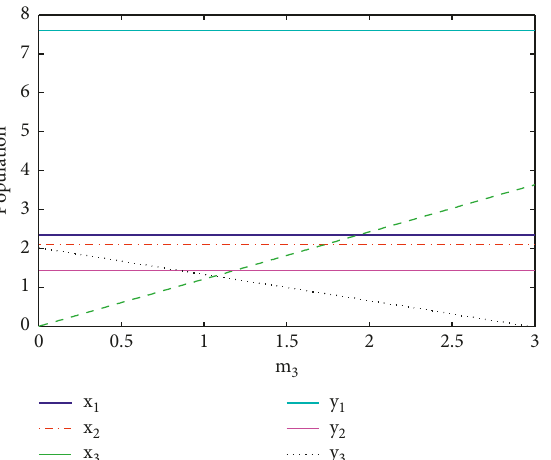
Figure 12: Variation of the system (1) with respect to k